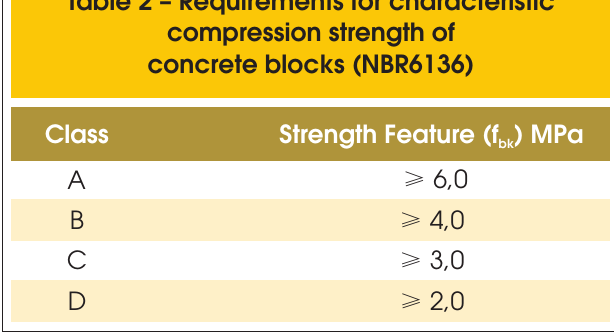
Table 2 – Requirements for